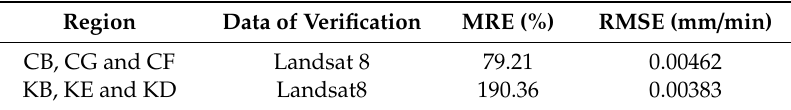
Table 6. Using Landsat 8 data to cross-verify the simulated ET of